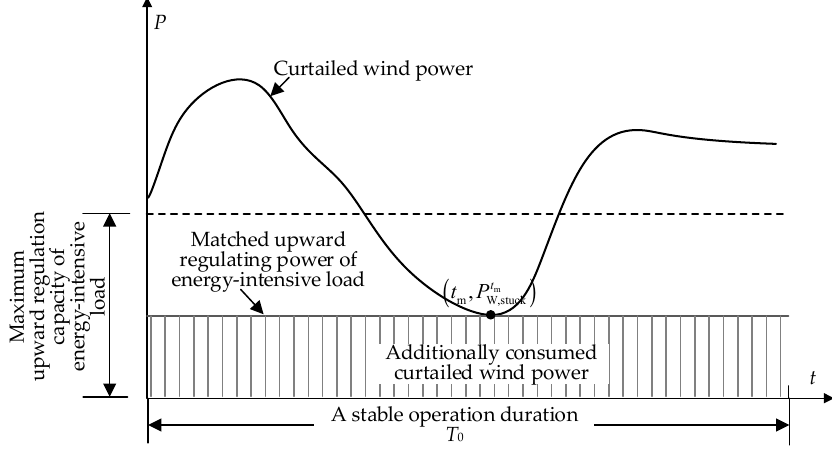
Figure 3. Curtailed wind power consumption with energy-intensive loads involved.